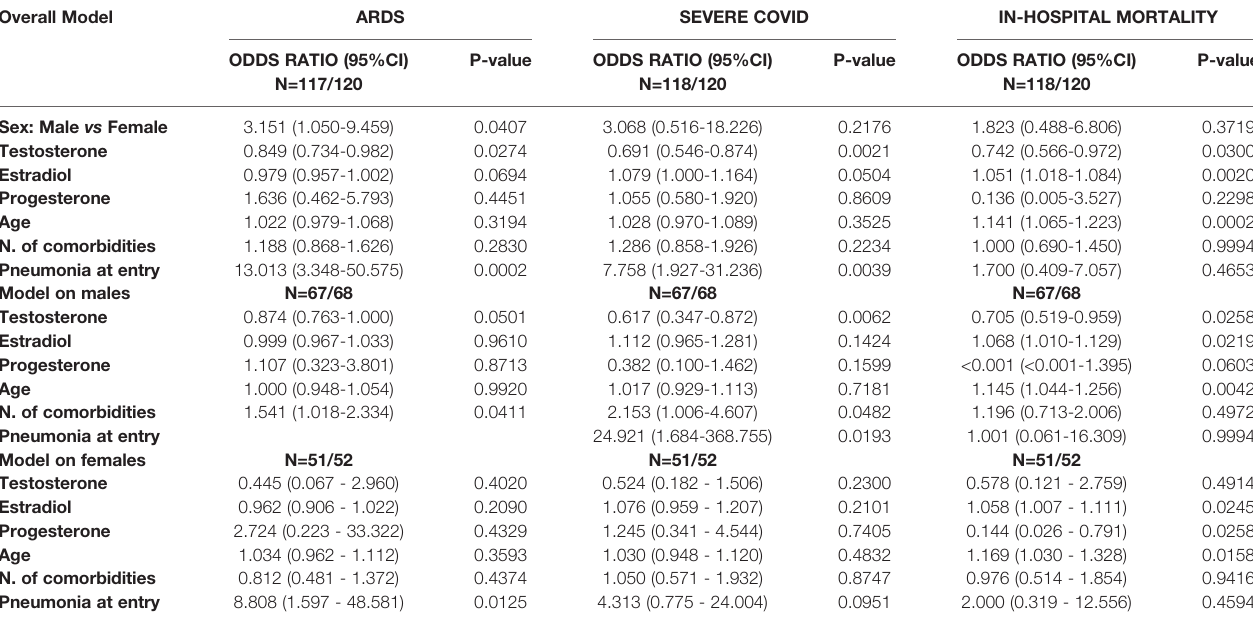
TABLE 5 | Logistic models on ARDS, severe COVID-19 and in-hospital mortality, overall and in the subset of male and female patients. Overall